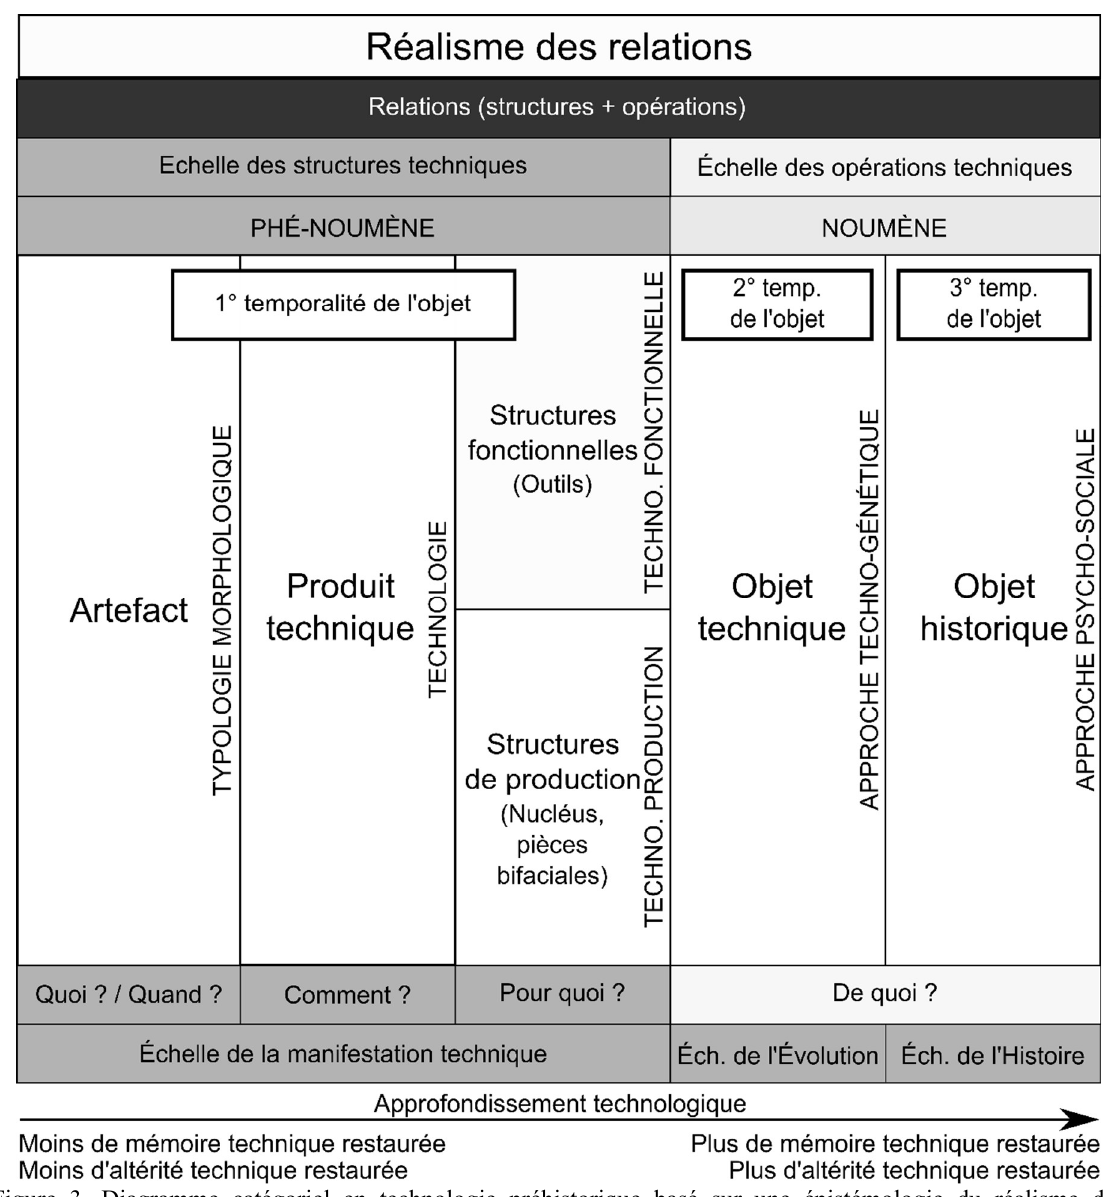
Figure 3. Diagramme catégoriel en technologie préhistorique basé sur une épistémologie du réalisme des